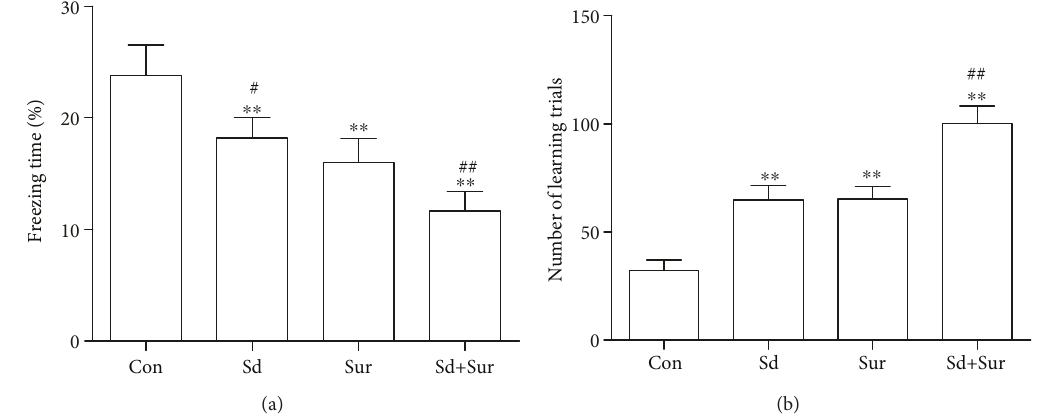
Figure 2: Preoperative sleep disturbance enhanced postoperative cognitive impairment in aged mice. (a) The freezing time in the contextual fear response task. (b) The number of learning trials in the Y maze test. The data are presented as the mean ± sem ( n = 12 ). ∗∗ P < 0 01 vs. the Con group; # P < 0 05 and ## P < 0 01 vs. the Sur group.